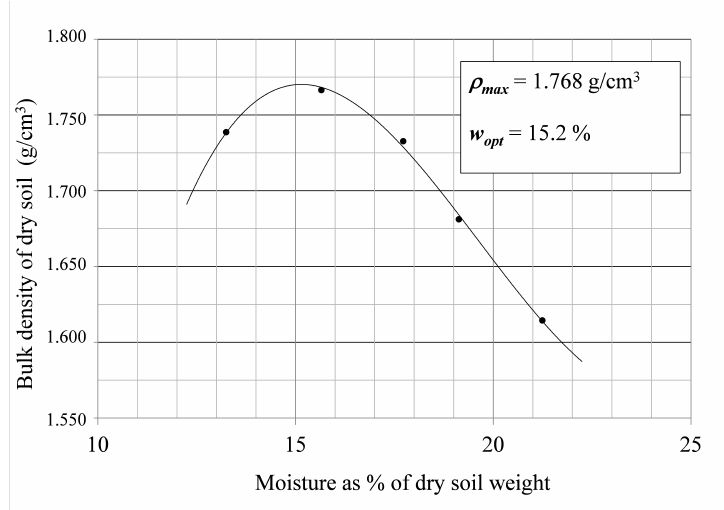
Figure 1. Determination of the maximum bulk density versus optimum moisture.